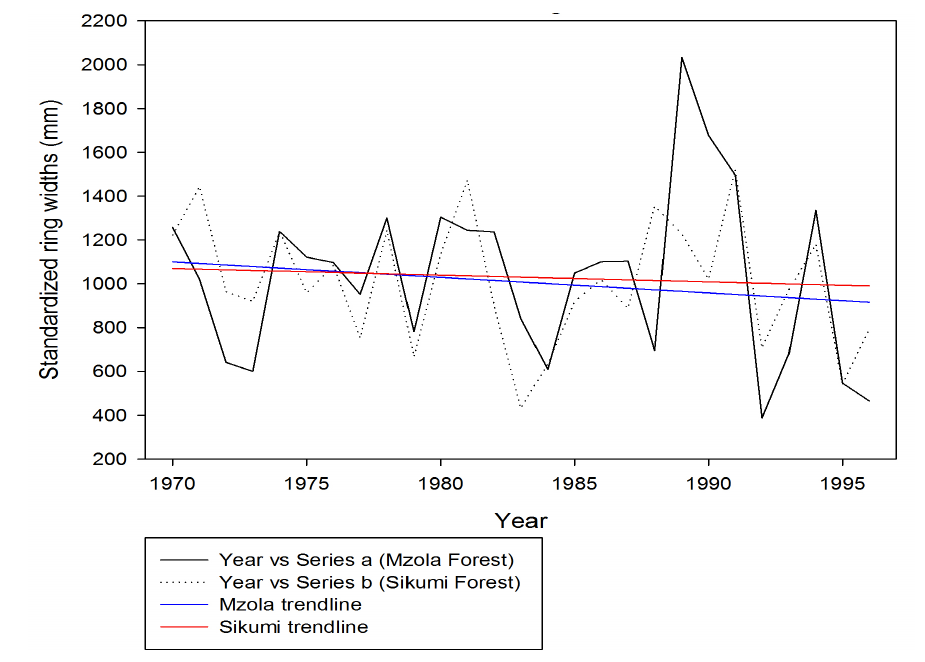
Figure 5. Standardized (ARSTAN) tree ring chronologies for the Pterocarpus species in Zimbabwe from Mzola Forest, from Mushove et al. [62] and Sikumi Forest, from Stahle et al. [60] (data downloaded from the International Tree-Ring Data